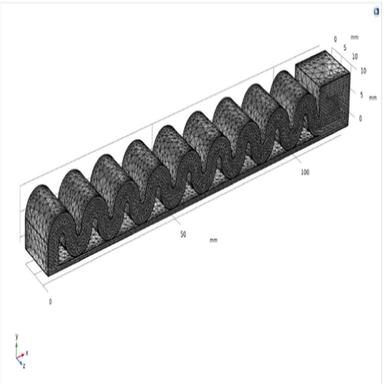
Computational mesh of the pneumatic actuator.